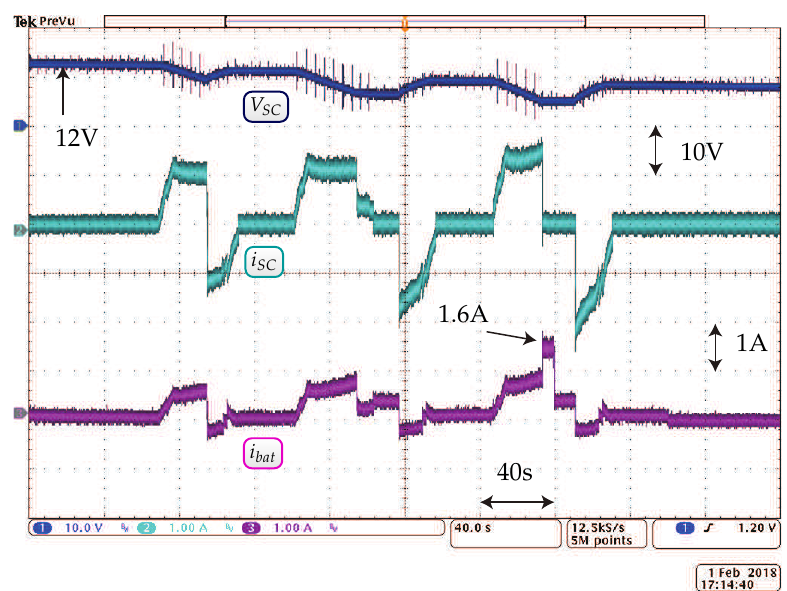
Figure 11. Experimental results for one-step predictive horizon single-objective optimization EMS with three typical stops in the driving cycle of the LR: SC current, SC voltage, and battery current.